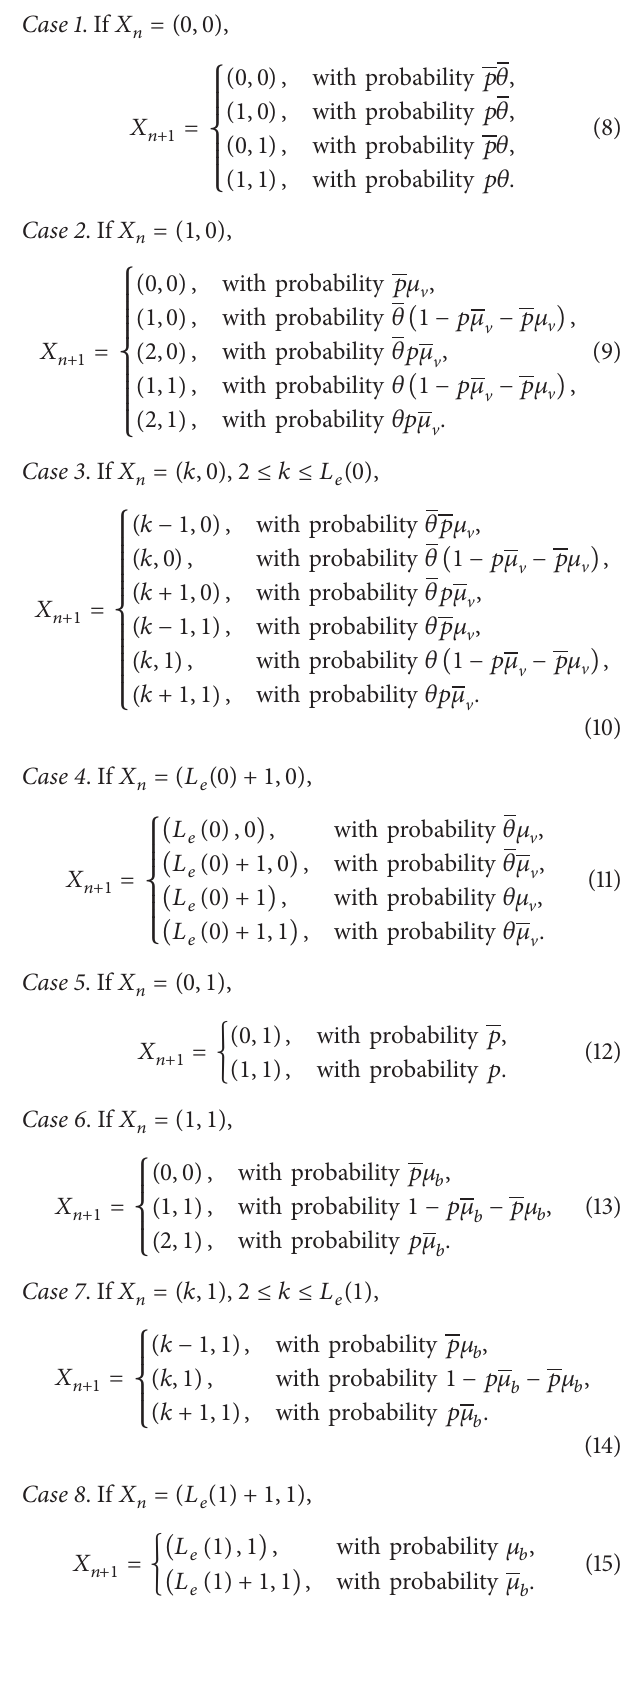
probability diagram in Figure 1. The one-step